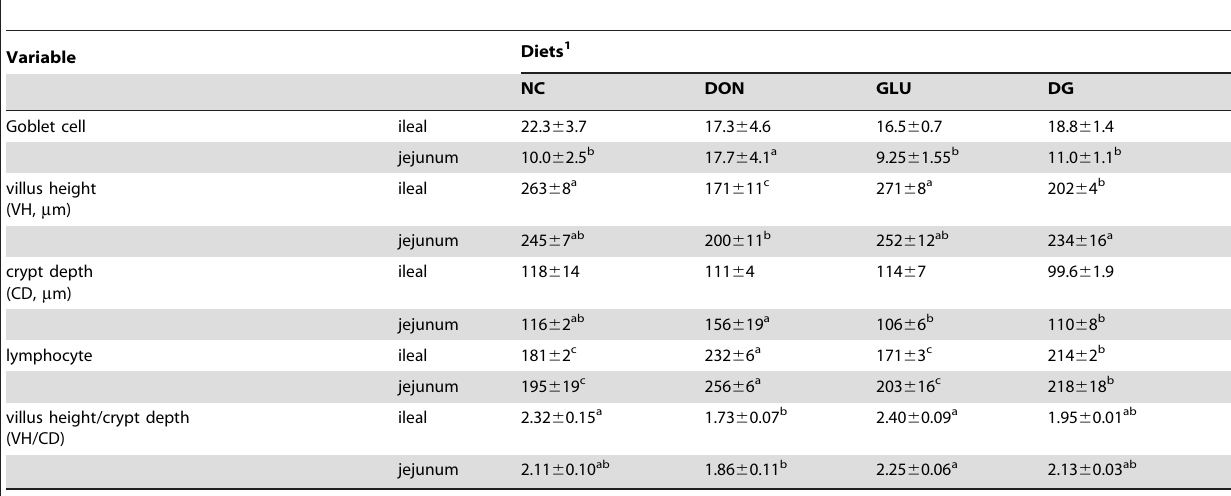
Table 3. Effect of glutamic acid supplementation on ileal and jejunum morphology in piglets fed a deoxynivalenol-contaminated diet.